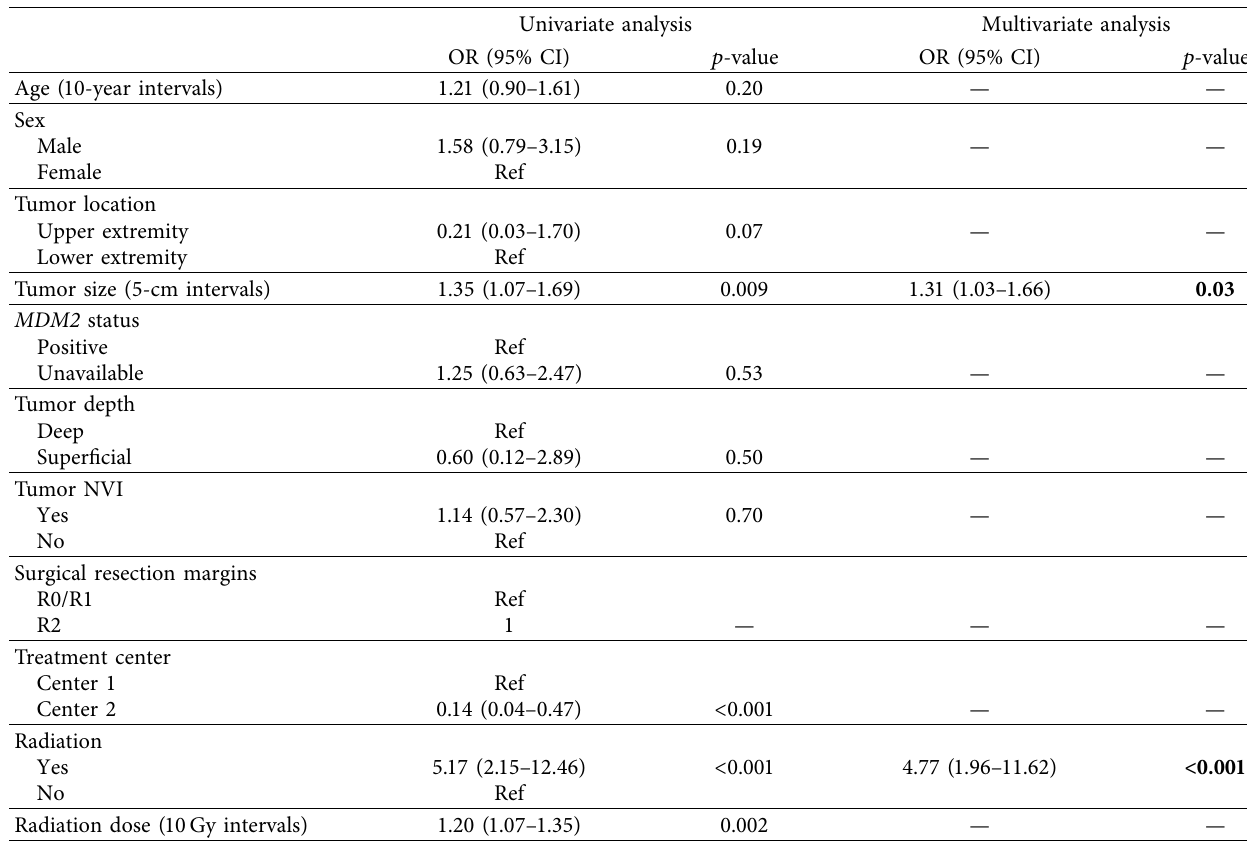
Figure 2: Time to recurrence or complication. Time to recurrence in 16 patients in the no-XRT group in blue (median 8.5 years (IQR 6.8–10.9)) is compared to time to surgical intervention for complication in eight patients in the XRTgroup in red (median 20.0 months (IQR 5.5–42.0)). Logrank comparison demonstrates overall difference in survival estimates p Table 5: Univariate and multivariate logistic regression analyses of patient characteristics with complication requiring medical or surgical